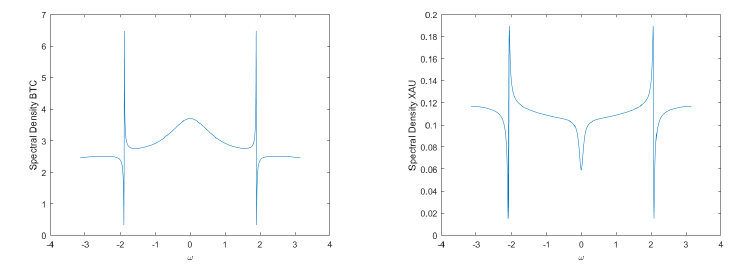
Figure A4. Power spectral density functions of Bitcoin and